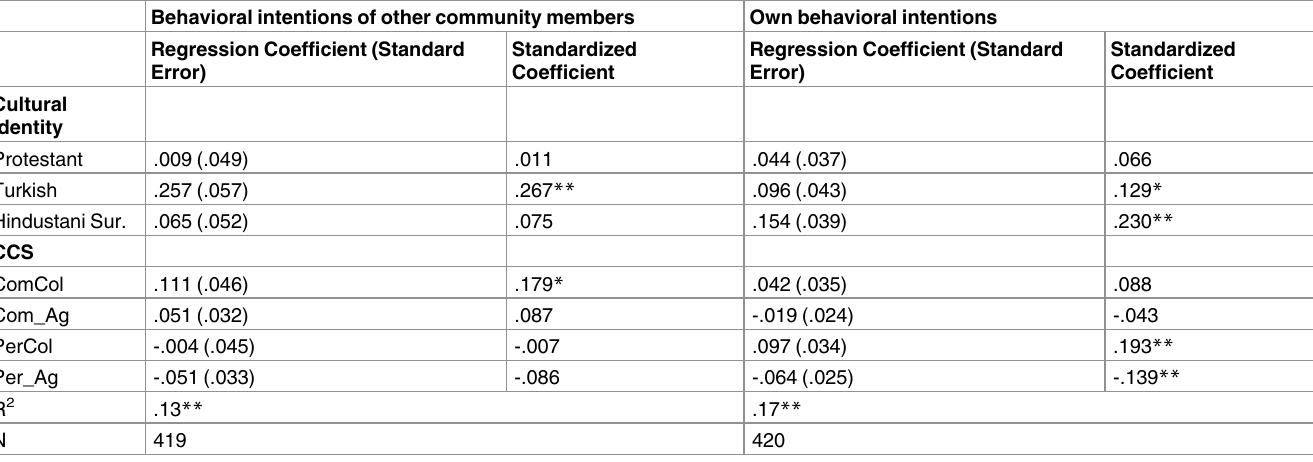
Table 9. Regression analysis: Individual behavioral intentions and those of other community memberspredicted by cultural identity and